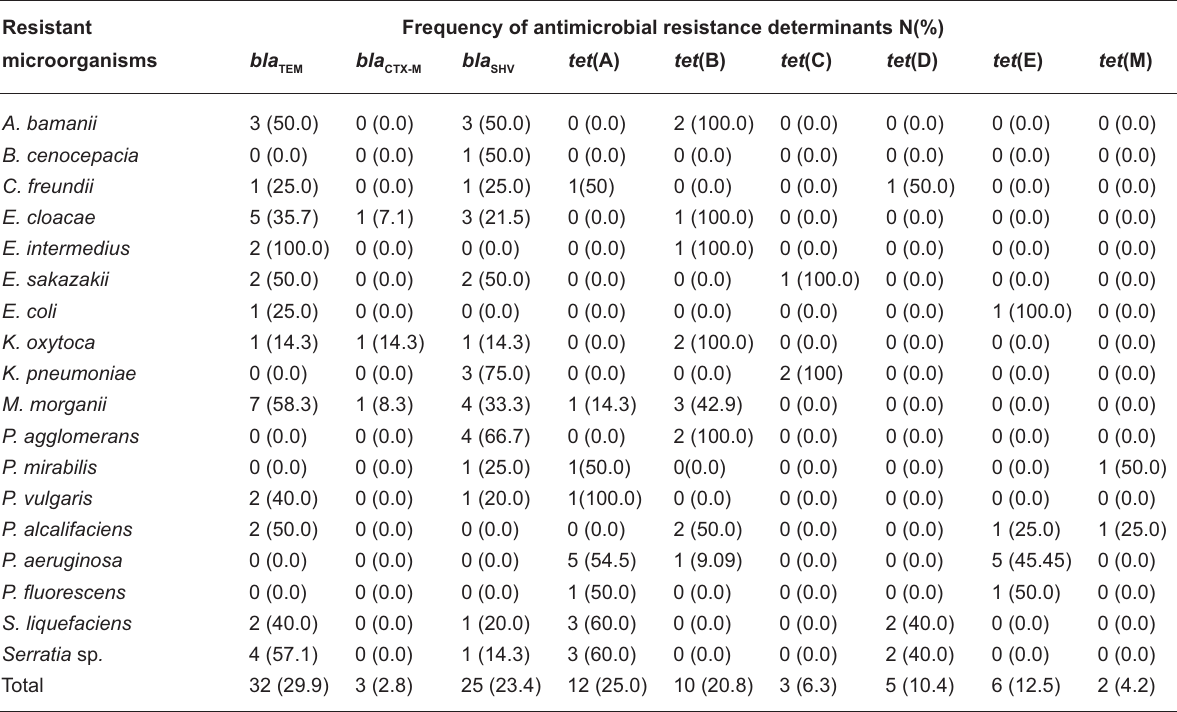
Table 2- Distribution of tetracycline and (cid:2) -lactam resistance genes in resistant Gram-negative isolates